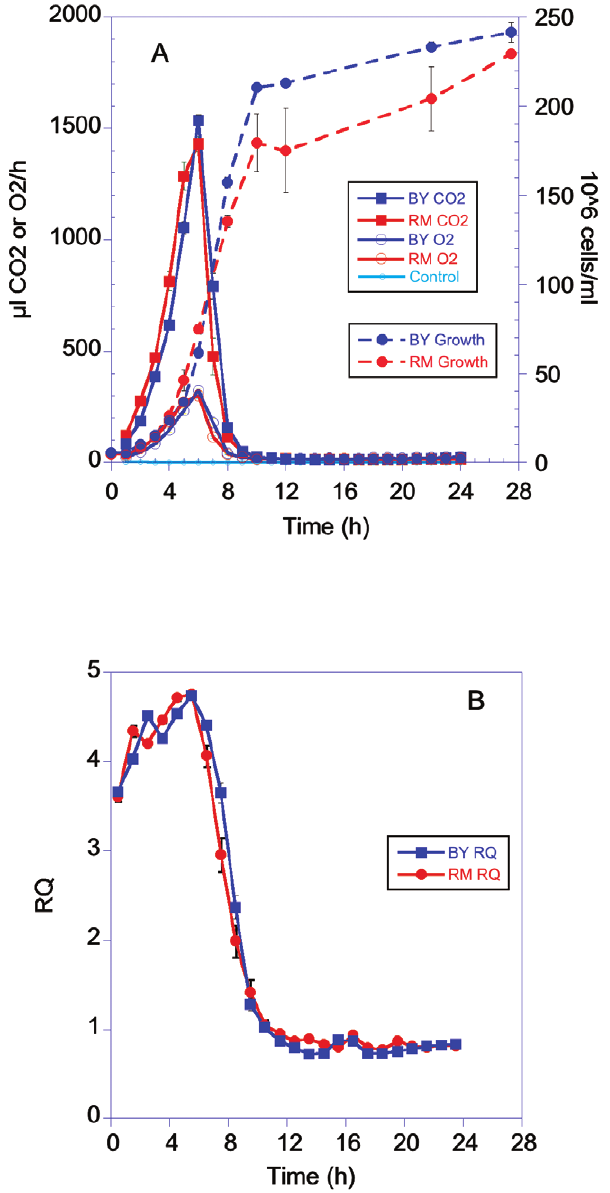
Figure 1. Metabolic rate, growth and respiratory quotient (RQ) of BY and RM grown in YP with 2% dextrose. Graphs are plotted using the means and sem of 6 groups for the CO 2 /O 2 measurements and for 3 groups for the growth measurements. Cell number per ml for figures 1 and 2 were calculated based on converting an optical density reading to an estimated cell number.